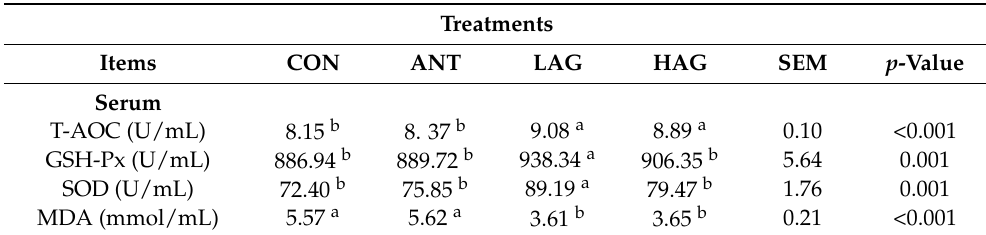
Table 5. Effects of Astragalus-Glycyrrhiza polysaccharides on antioxidant function of broiler’s serum and breast